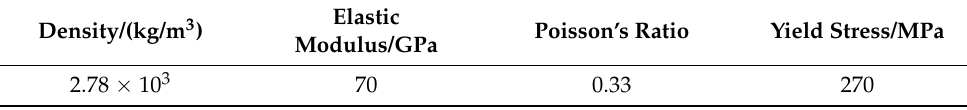
Figure 2. Flowchart of generating round pores. Table 1. Copper–aluminum alloy substrate material